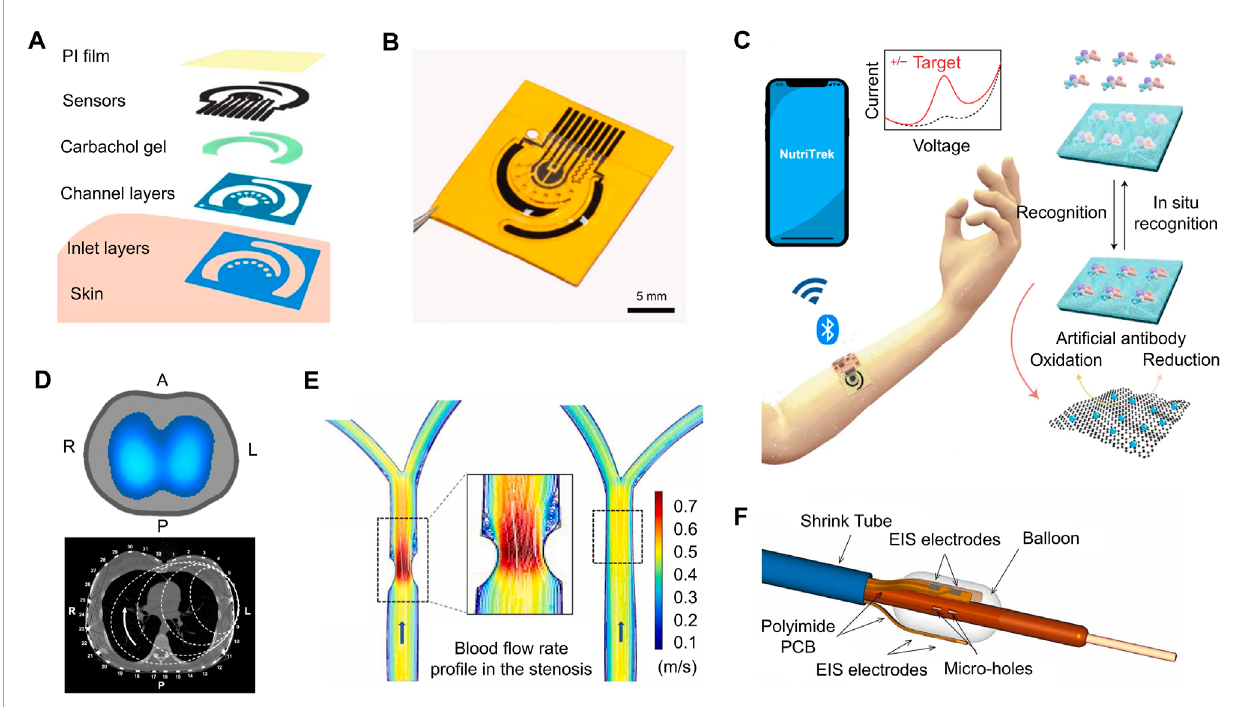
FIGURE 7 (A) A flexible patch for the detection of metabolites is comprised of a polyimide film, an electrochemical sensor, as well as several other layers to aid in signal conduction. (B) A three-dimensional rendering of the electrochemical sweat sensor. (C) IoT technology allows data from wearable electrochemical sensors to be synchronized to the cloud. Physicians could monitor such information in real time, further improving personalized healthcare. (D) An EIT belt is capable of diagnosing medical conditions by producing an impedance map of various organs, such as the lungs. (E) Blood flow restriction is present in the right carotid artery due to atherosclerosis. (F) EIS balloon catheter using six electrodes to develop 3-D images intravascularly. [adapted and modified from (Bachmann et al., 2018; Abiri et al., 2022; Wang M. et al.,